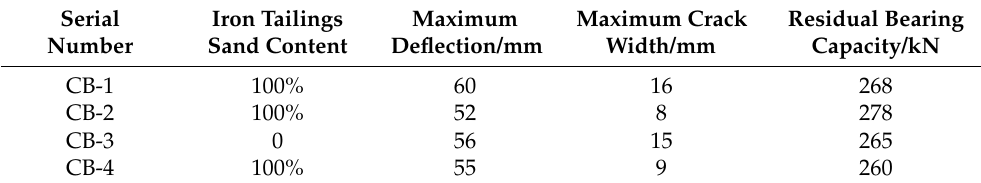
Table 4. Statistics of continuous beam test results after